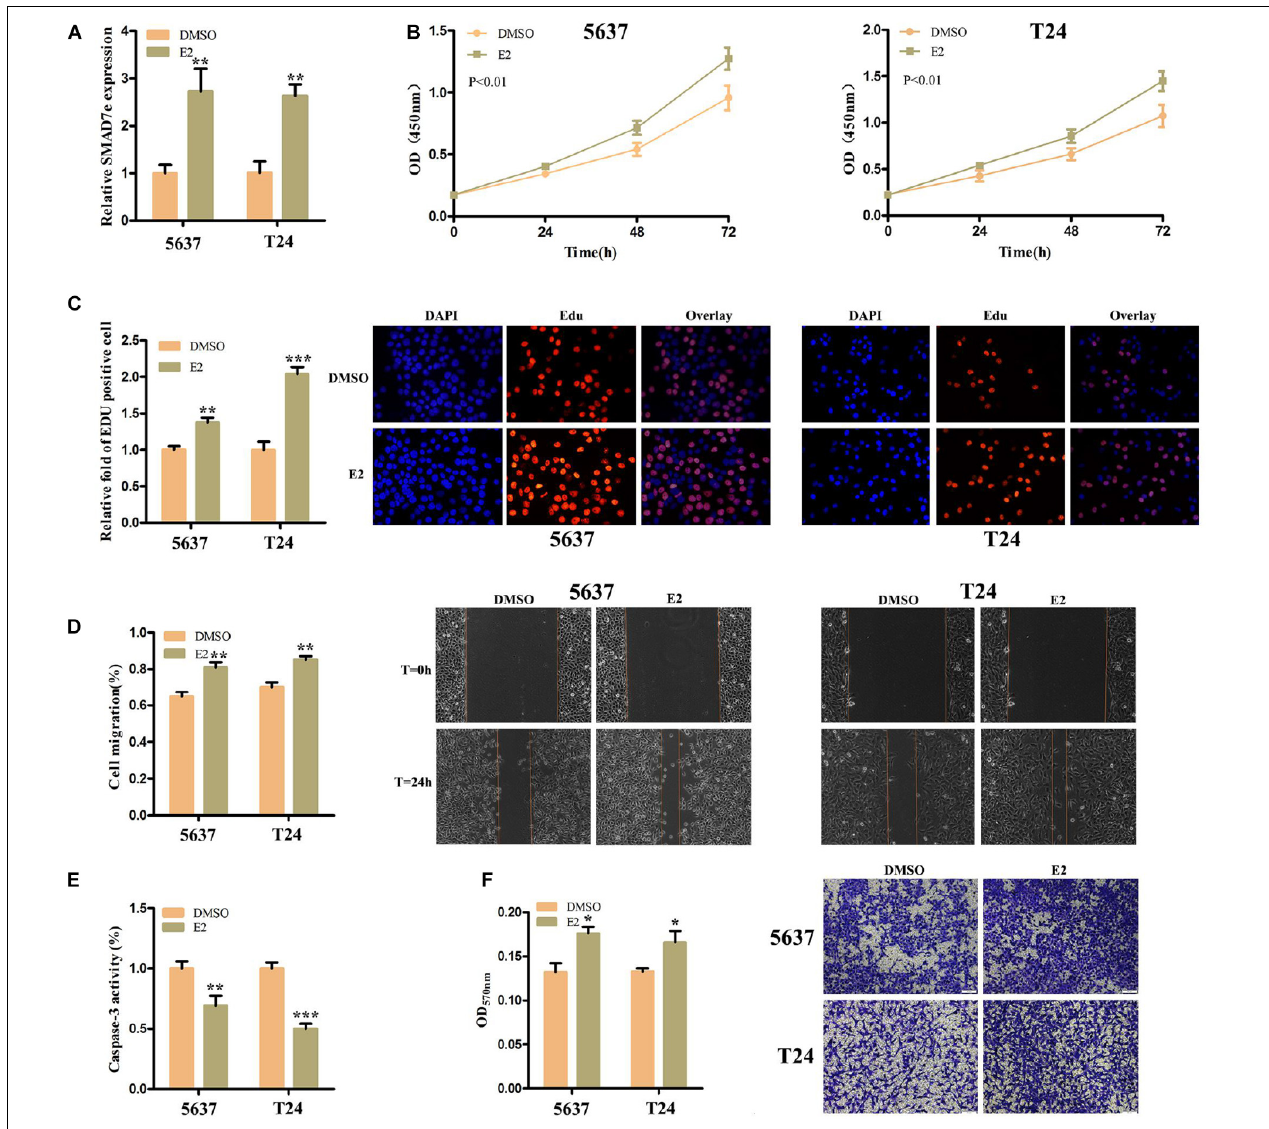
FIGURE 2 | The effect of E2 on bladder cancer cells. (A) After stimulation with estrogen for 1 h, the relative expression levels of SMAD7e were significantly increased in bladder cancer cells. (B,C) Estrogen facilitated cell proliferation as revealed by CCK8 and Edu assays in 5637 and T24 cells. (D) Estrogen promoted cell migration as revealed by wound healing assays in 5637 and T24 cells. (E) Estrogen reduced bladder cancer cell apoptosis. (F) Estrogen increased cell invasion as detected by Transwell R (cid:13) assays. E2 represents estrogen. Data are shown as the mean ± SD (* p < 0.05, ** p < 0.01, *** p <